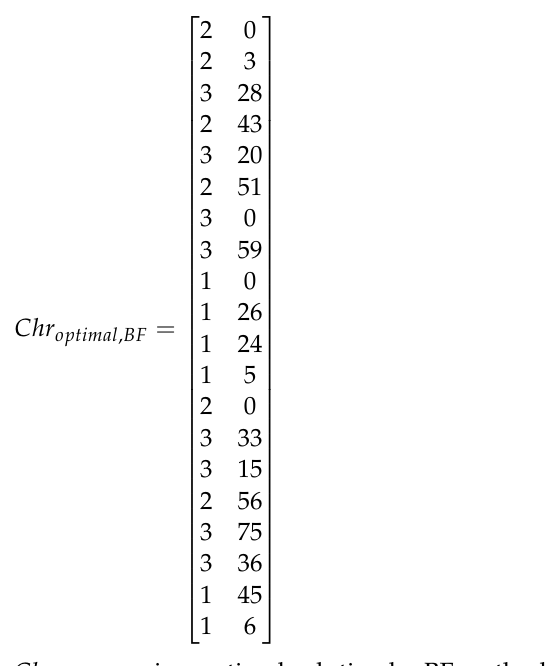
Figure 11. The FF and BF methods in Type A. ( a ) The FF method; ( b ) The BF method. In Figure 11, the minimum travel distance is nearly 205 (the optimum of BF method line shows at the end of iteration) using BF method, obviously 228 using FF method, these represents a reduction of 11.2% in travel distance (Tokola and Niemi [26], optimization of the rule gaps are narrower than 10%). It is validated that MRCGA has an obvious advantage in solving DC problems. At the same time, one of the optimal solutions is shown in Formula (14).